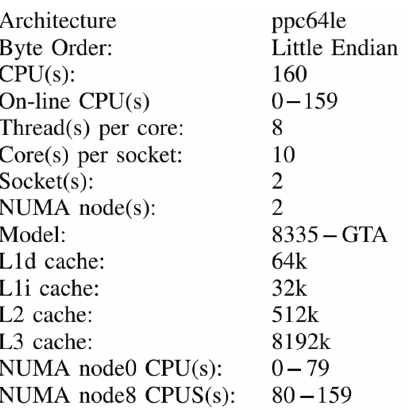
Figure 1. General logic diagram of Quinde I.